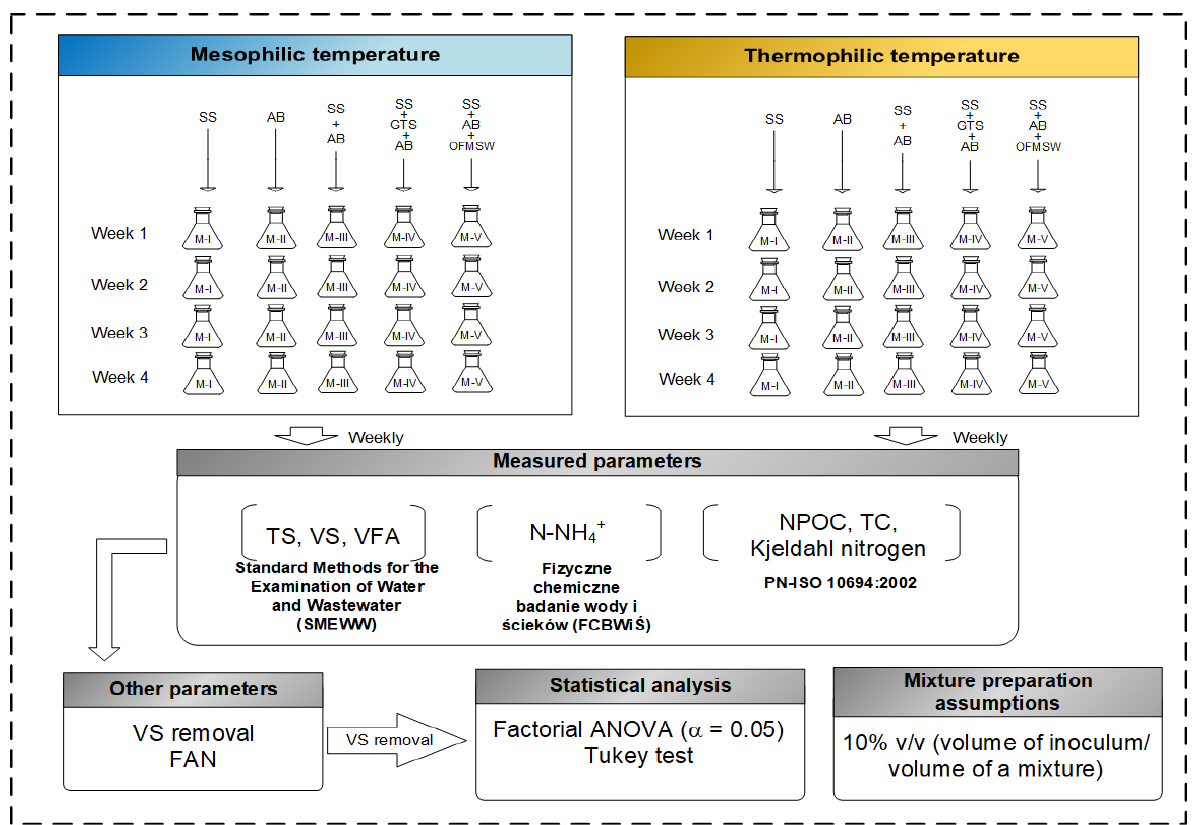
Figure 2. Scheme of experiment related to the physicochemical analysis.